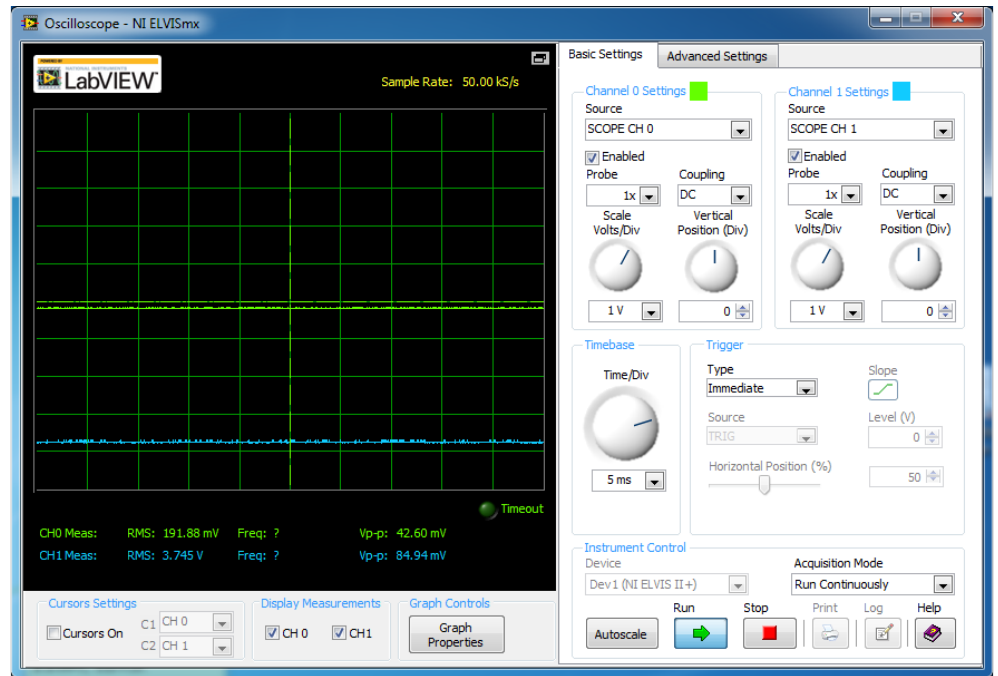
Figure 10. Soft front panel oscilloscope of NI ELVISmx.